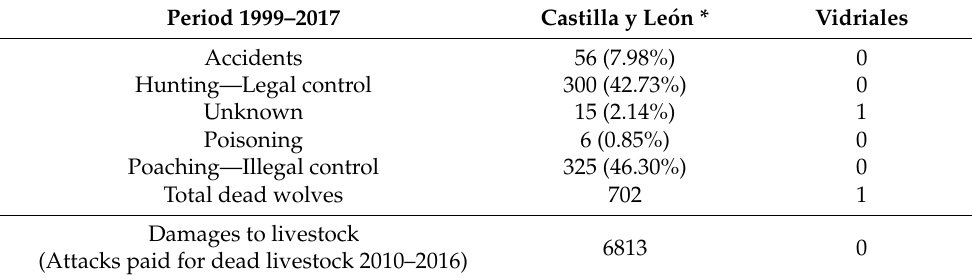
Table 7. Number of wolves found dead in the areas of